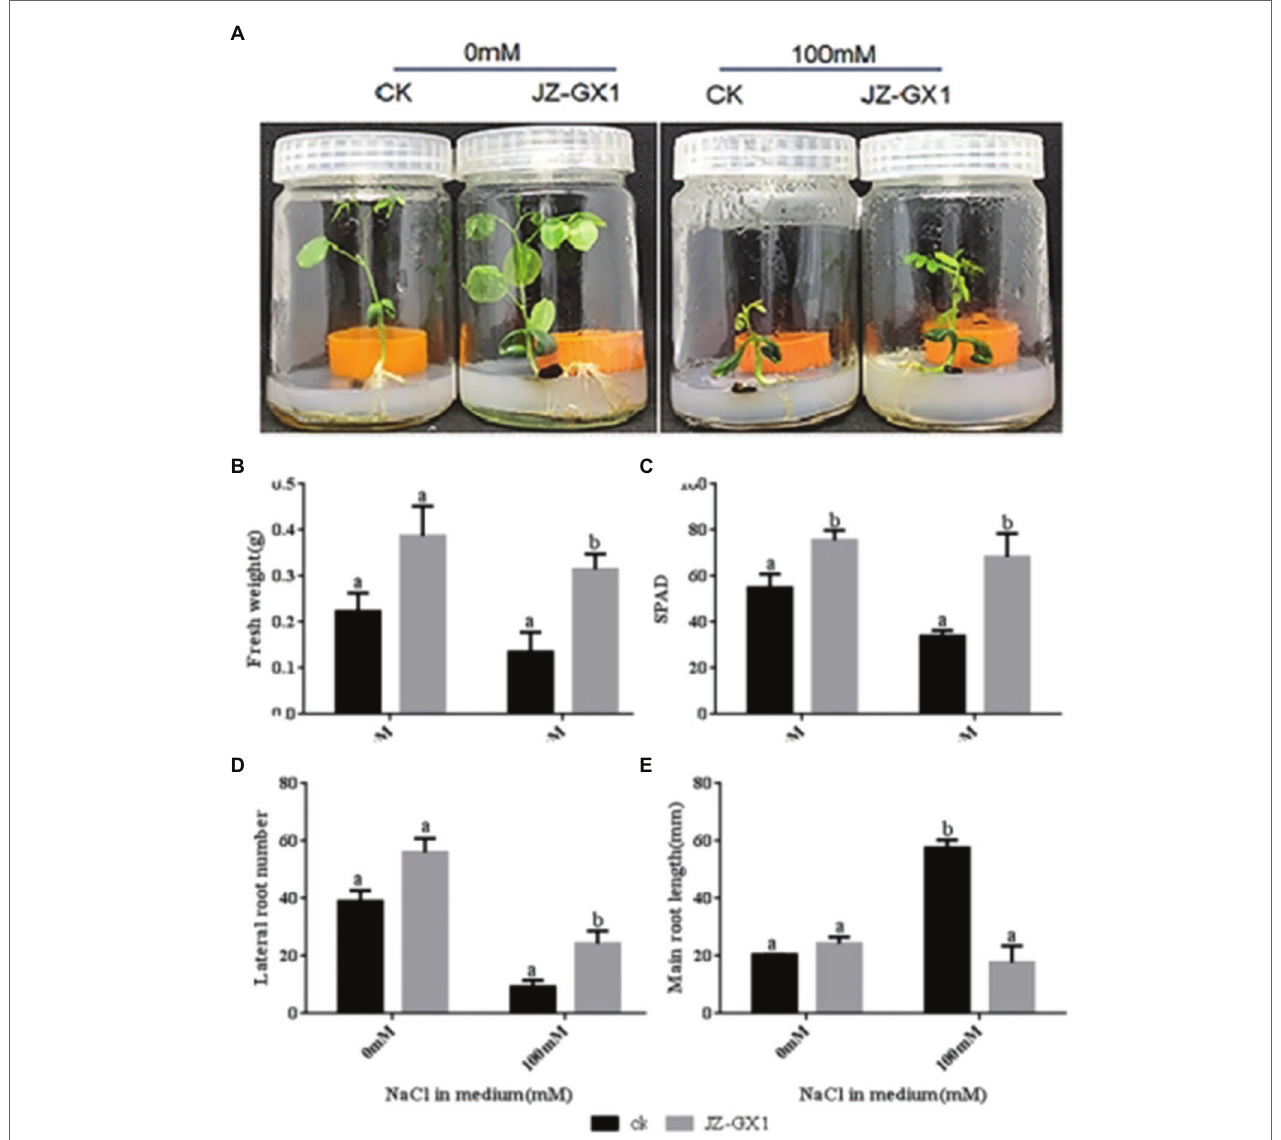
FIGURE 2 | Effect of volatile gas from R. aquatilis JZ-GX1 on the growth of R. pseudoacacia . (A) phenotype; (B) fresh weight; (C) soil and plant analyser development value; (D) lateral root number; (E) primary root